Question: Judging by this figure, is the value going up or going down?
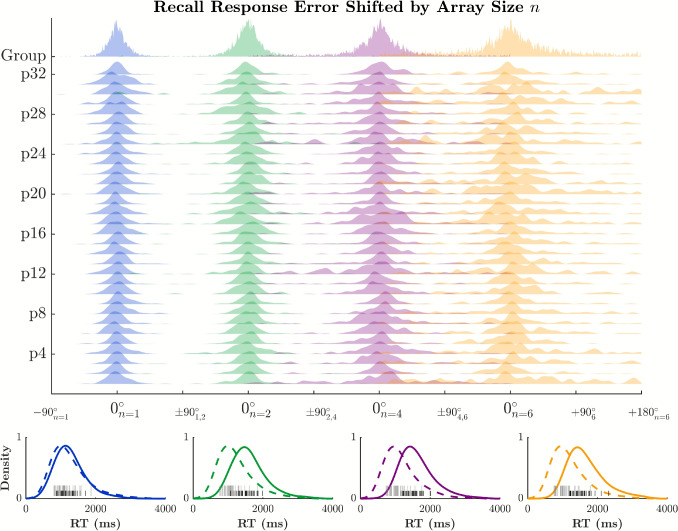
Answer: increasing